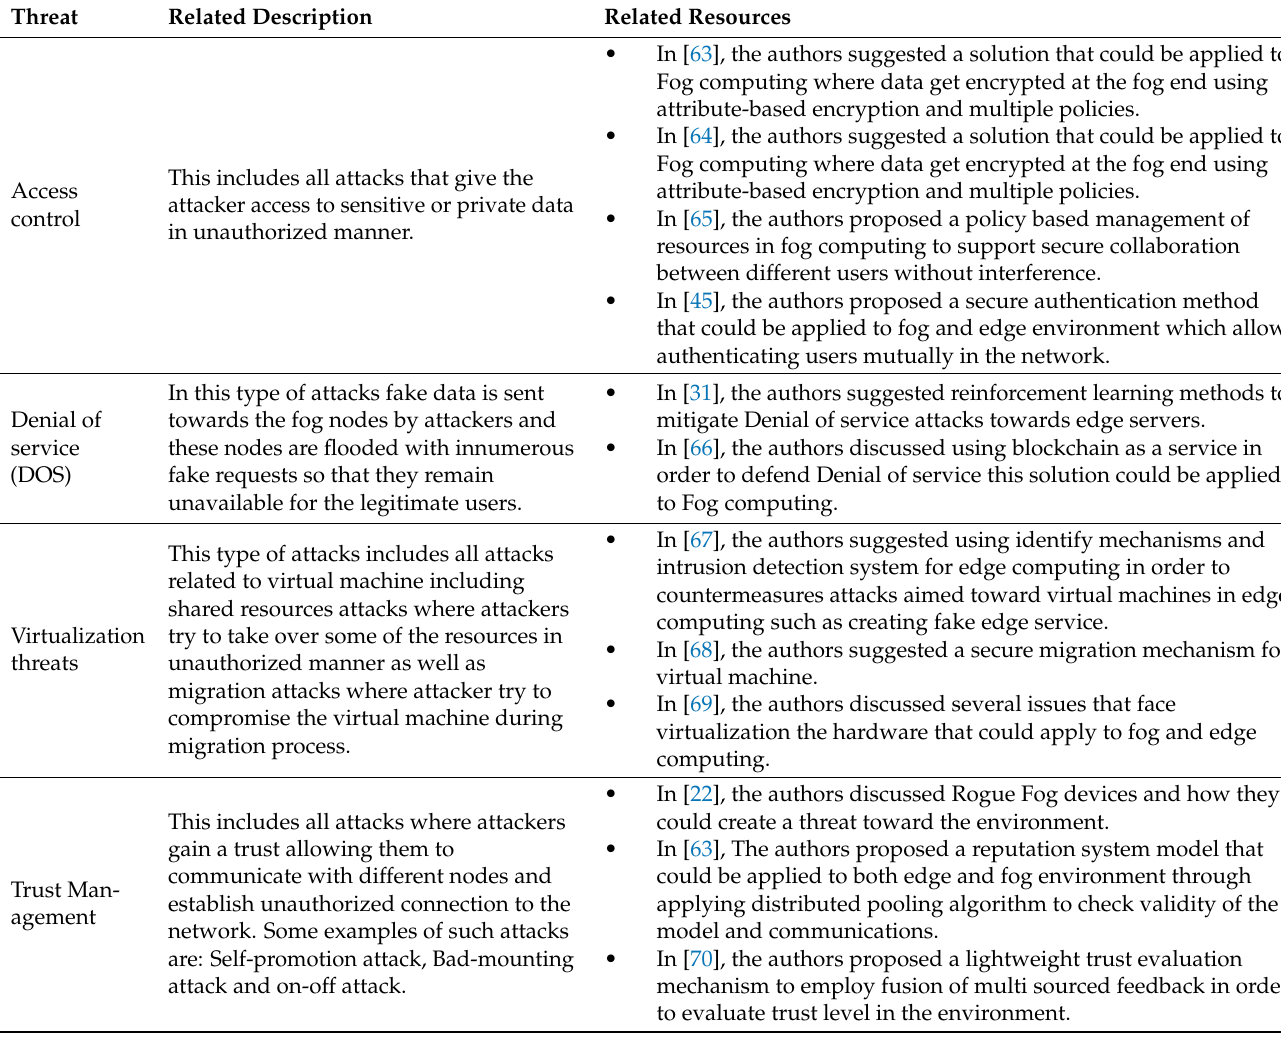
Table 7. Main threats of fog and edge computing and related